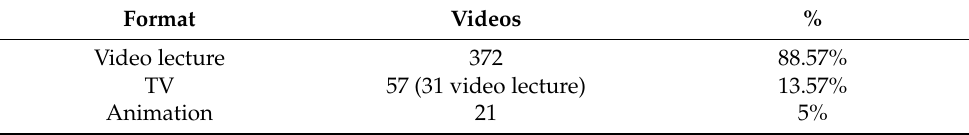
Table 2. Formats of the